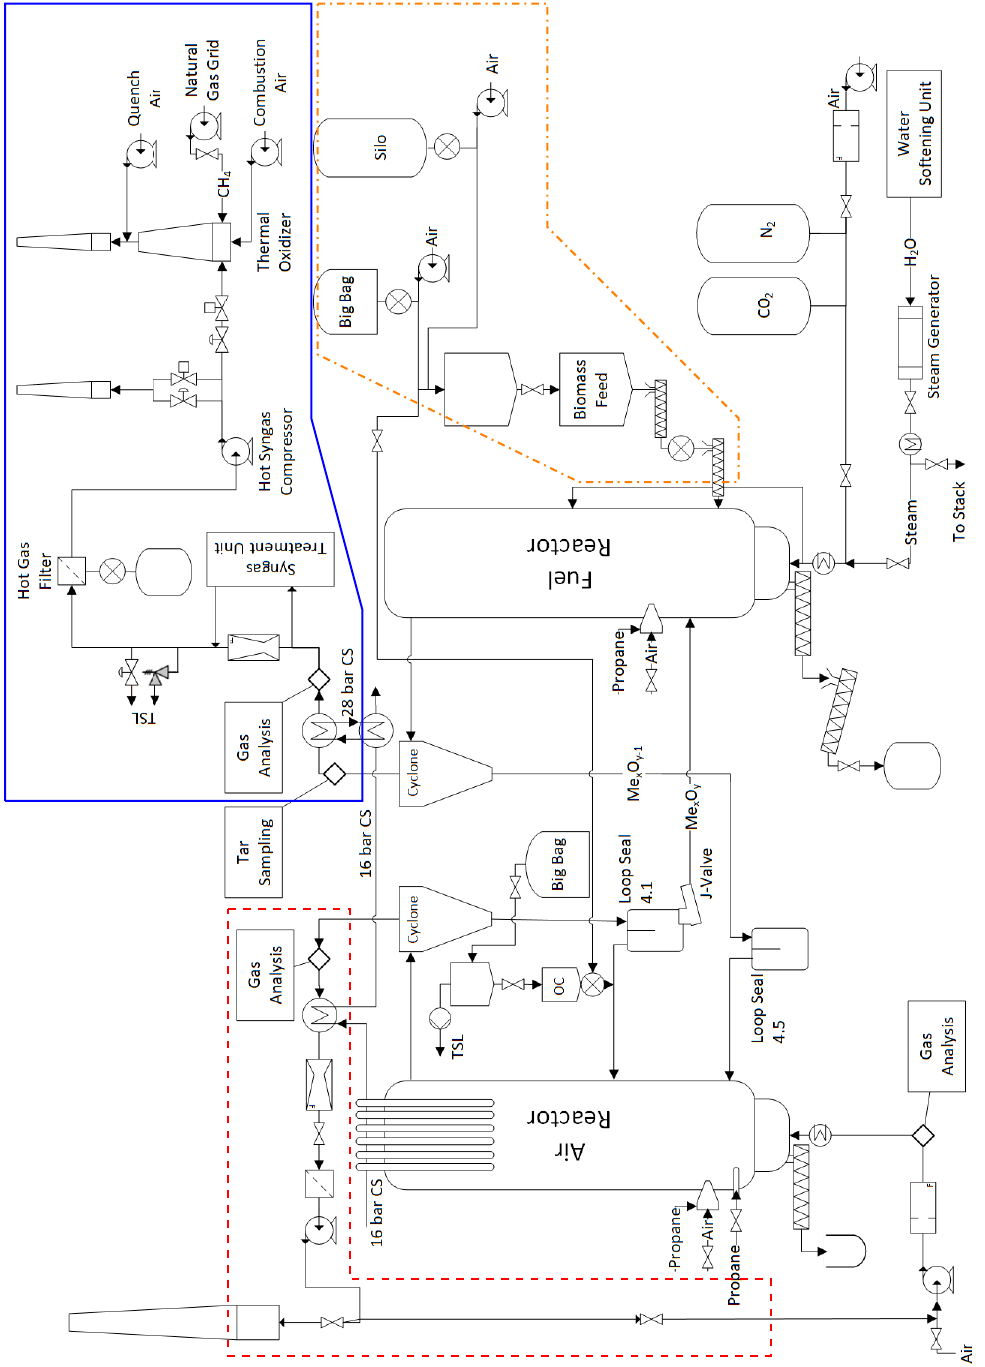
Figure 4. Schematic of the CLG pilot plant showing the main subsystems. CS: cooling system, OC: oxygen carrier, TSL: to safe location. syngas handling: , flue gas handling: , biomass feeding: